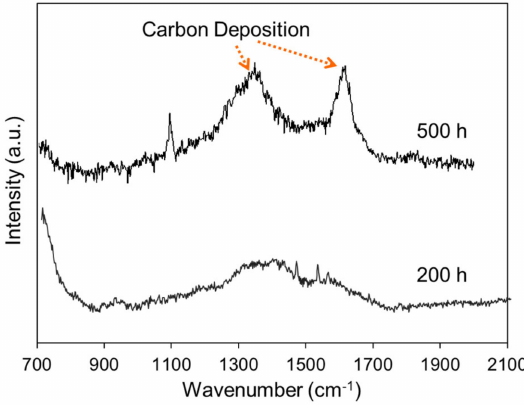
Figure 9. Raman spectroscopy of Cat-1 after